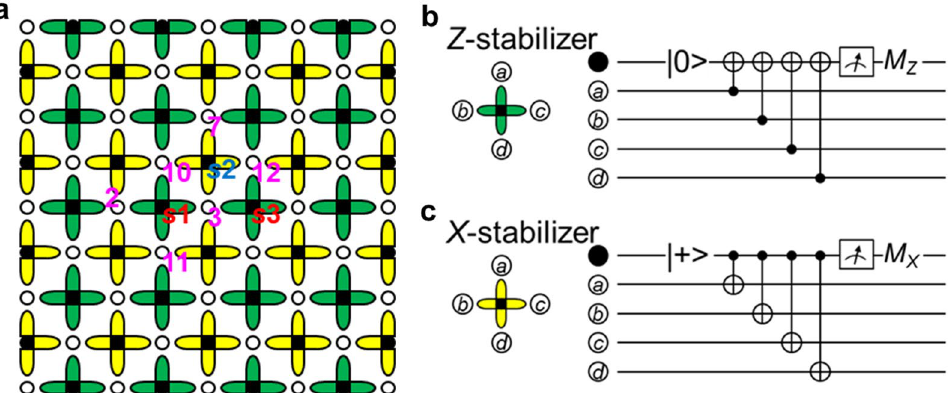
Figure 1. Schematic surface code. ( a ) Open circles show data qubits with information; solid circles show syndrome qubits that are ancillas. Data qubits interact with syndrome qubits through green and yellow edges. The syndrome qubits surrounded by green edges are assigned to detecting a bit-flip error; those surrounded by yellow edges are assigned to detecting a phase-flip error. Pink numerals indicate the positions of data qubits. Red and blue symbols starting “ s ” indicate the positions of syndrome qubits. ( b ) Circuit for detecting a bit-flip error. ( c ) Circuit for detecting a phase-flip